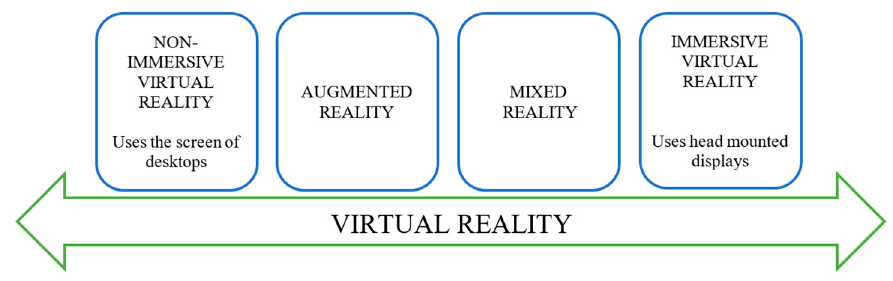
Figure 1. Immersive and non-immersive Virtual